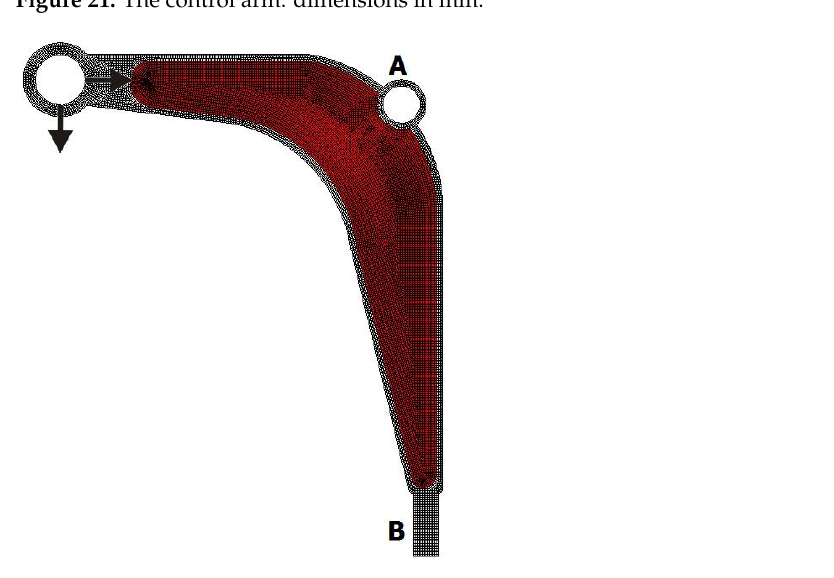
Figure 22. The design domain, loads, and supports of the control arm.